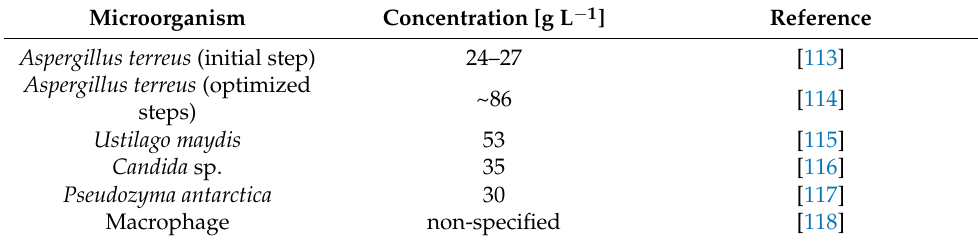
Table 3. Microorganisms reported as efficient producers of itaconic